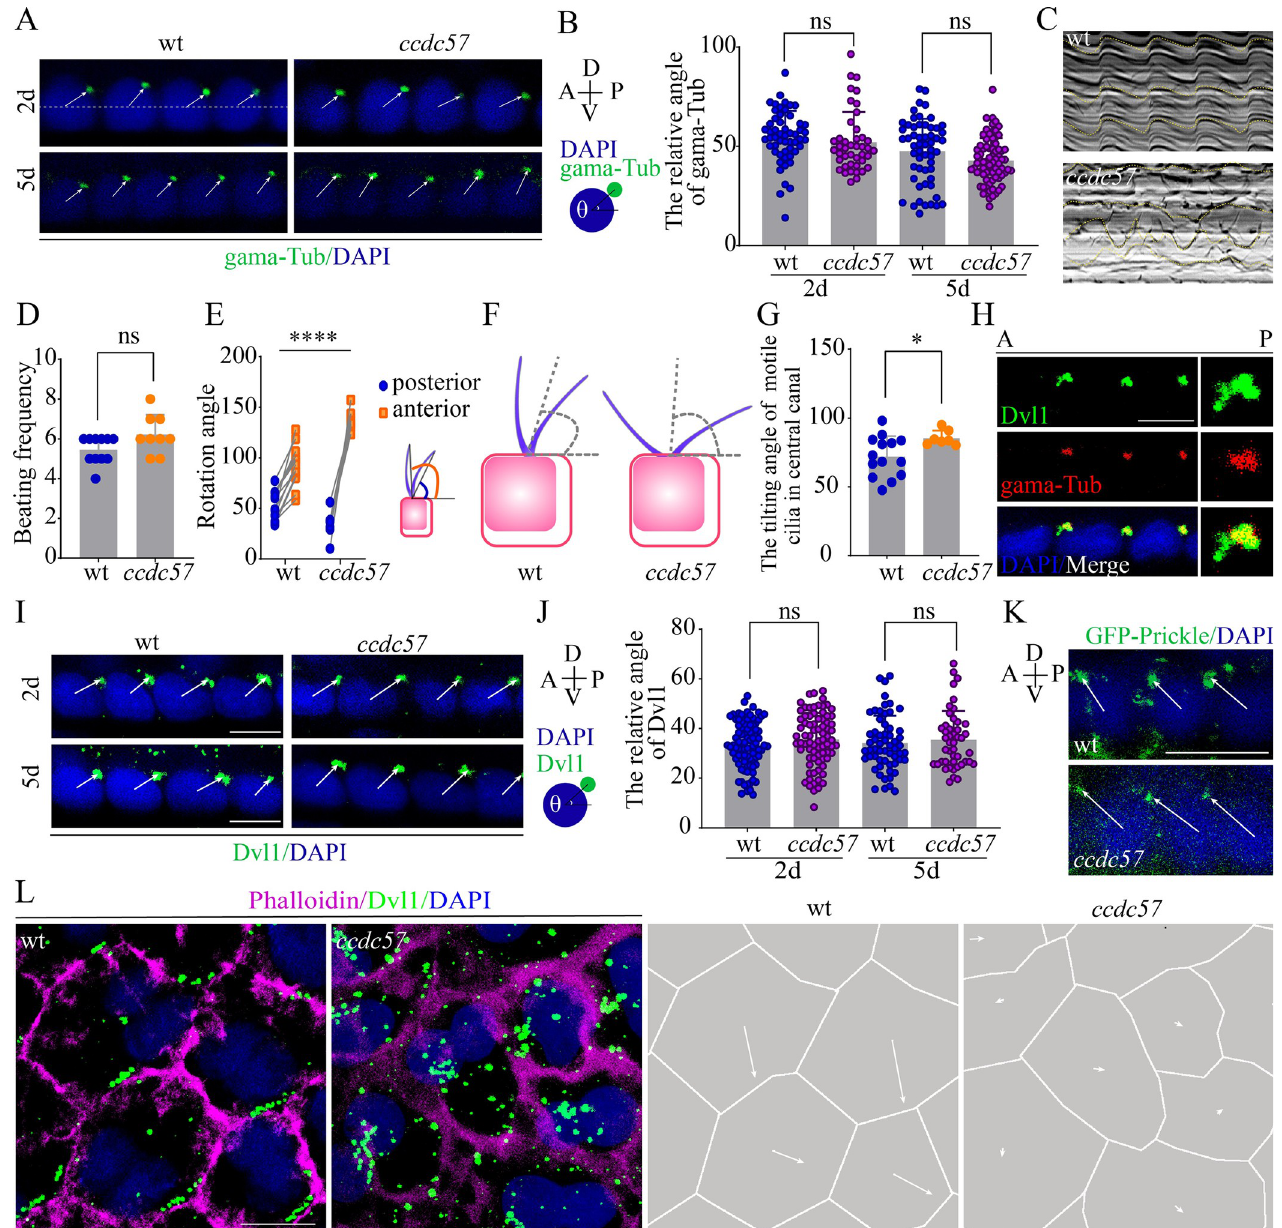
Fig 5. Ccdc57 orchestrates synchronized beating of motile cilia in the central canal. ( A ) Confocal images showing the localization of basal bodies in the floor plate cells at 2 dpf and 5 dpf. Basal bodies were stained with anti- γ tubulin (gama-Tub, green) antibody, and nuclei were counterstained with DAPI in blue. The white dotted line connects the center of cells. ( B ) Statistical analysis showing the angles of basal bodies with the anterior–posterior (A–P) axis as illustrated in the diagram. ( C ) Still images showing kymographs of floor plate cilia movement in 5 dpf of wild type and ccdc57 mutant. ( D ) Beating frequency of floor plate cilia in wild type and ccdc57 mutants. ( E ) Statistical analysis showing the rotation angles of cilia in floor plate. The anterior and posterior angles were measured as illustrated in the diagram. ( F , G ) Relative tilting directions of floor plate cilia in wild type and ccdc57 mutants. The tilting direction was evaluated by the bisector of each angles. ( H ) Confocal images showing relative localization of Dvl protein (green) and basal body (gama-Tub, red) in floor plate cells. ( I , J ) Subcellular localization of Dvl protein (green) in the floor plate ependymal cells. The statistical results were shown in panel J. ( K ) Confocal images showing the localization of GFP-Prickle (green) in floor plate ependymal cells as indicated. ( L ) Confocal images showing the distribution of Dvl protein (green) on ependymal cells of adult zebrafish. The displacement distance of Dvl vesicles was also shown on the right. Scale bars: 5 μ m in panel A; 5 μ m in panels H and I; 10 μ m in panel K; 7.5 μ m in panel L. The data underlying the graphs shown in the figure can be found in S1 Data.